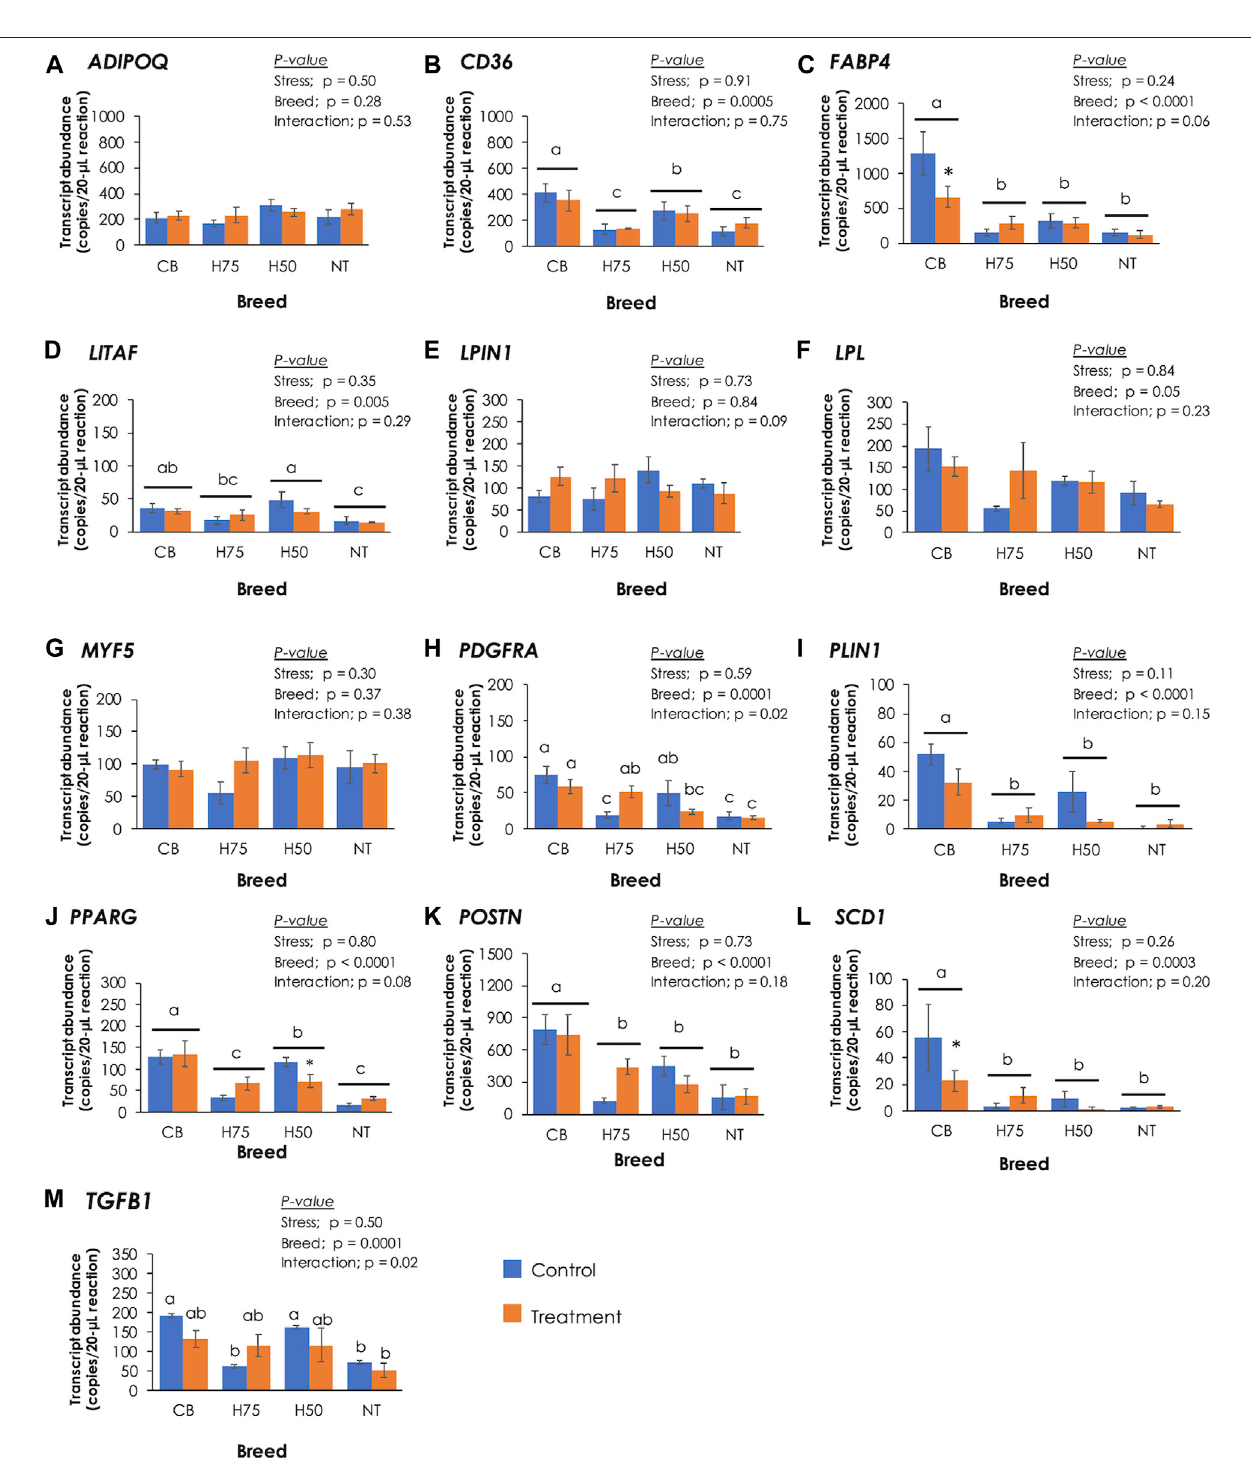
FIGURE4 | Absolutetranscriptabundance of13 target genes associated with lipid metabolismsand muscleinjuryin the pectoralis major muscle ofchickens from different breeds. The birds werereared at a constant temperature (control, 26 ° C) or received heatchallenge (treatment, 35 ° C, 6 h daily) for 20 days before reaching their market ages. Bars and error bars depict average and standard error in copies per 20-µL reaction, respectively. CB: commercial broilers; H75: crossbreeds, 75% broiler background and 25% Thai native background; H50: crossbreeds, 50% broiler background and 50% Thai native background; NT: Thai native chicken. Different lettersaboveindividualbarsdenotestatisticalsigni fi canceamongdifferenttreatmentgroups( p < 0.05).Differentlettersabovehorizontallinesindicatesigni fi cancedueto different breeds ( p < 0.05). Asterisks indicate the reduced expression of particular genes in stressed samples compared to their control counterparts ( p < 0.05).